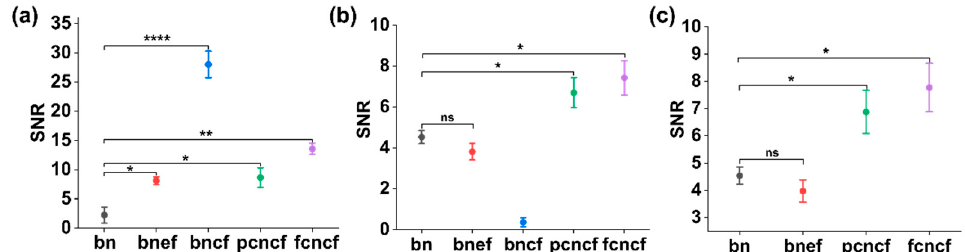
Figure 7. Signal-to-noise ratio (SNR) measurements for photoacoustic images acquired during in- plane needle insertions into a pork joint tissue ex vivo. ( a ) SNR improvement on the needle tip, ( b ) SNR improvement on the needle shaft, and ( c ) SNR improvement on the needle including the needle shaft and tip. bn: bare needle; bnef: bare needle with the tip-exposed fibre; bncf: bare needle with the tip-coated fibre; pcncf: partially coated needle with the tip-coated fibre; fcncf: fully coated needle with the tip-coated fibre. Data represent mean values and error bars represent standard errors. * p < 0.05, ** p < 0.01, **** p < 0.0001, ns: not significant.